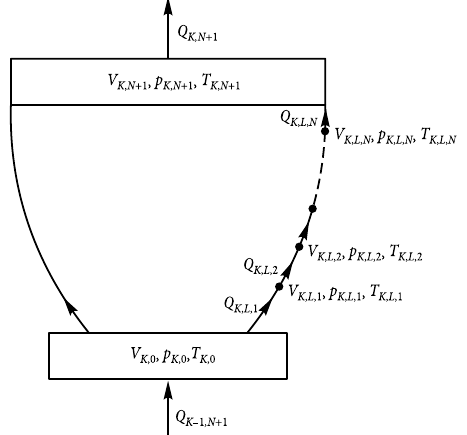
Fig. 1. Computational scheme of the pump Fig. 1 represents the discrete computational scheme of one stage of the 16-stage centrifugal pump. Equations are solved using the concentrated parameter method, conducting geometrical characteristic and other prop- erties of each blade.